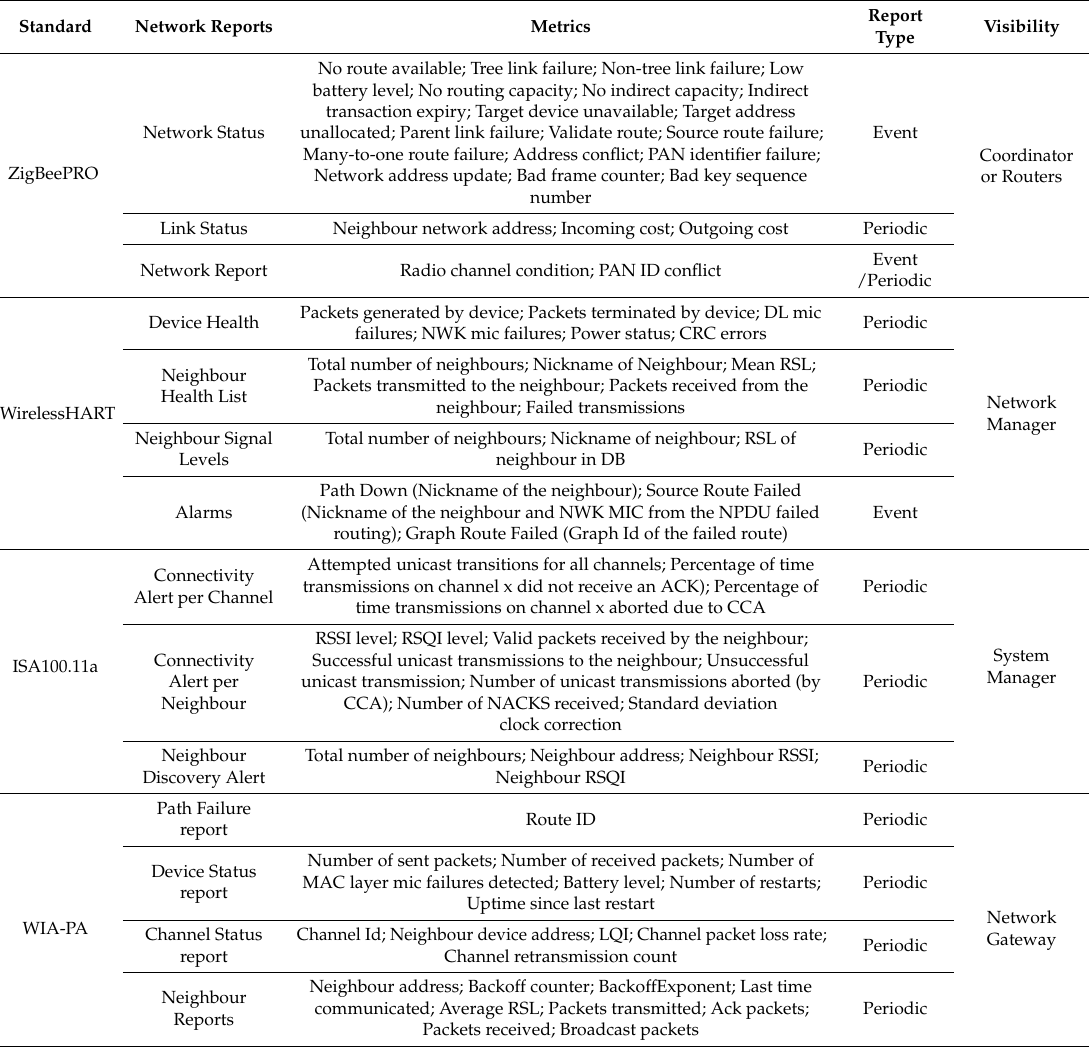
Table 2. IWSN Network